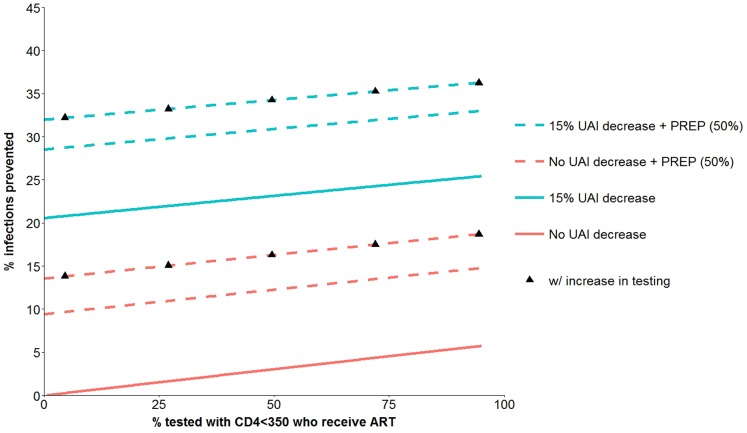
HIV infections prevented over 5 years from combination prevention interventions with four components.ART coverage of eligible persons who were not already receiving ART at baseline, PREP with 50% acceptance (dotted lines), 15% UAI reduction (blue lines; no UAI change are in red) and increase in HIV testing (black triangles). See Table 1 for further details about the components of the prevention interventions.